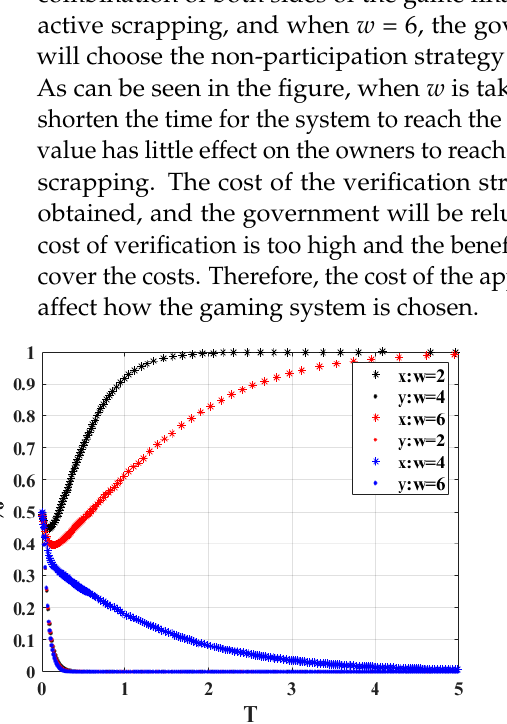
Figure 7. Sensitivity analysis of “ w ”.